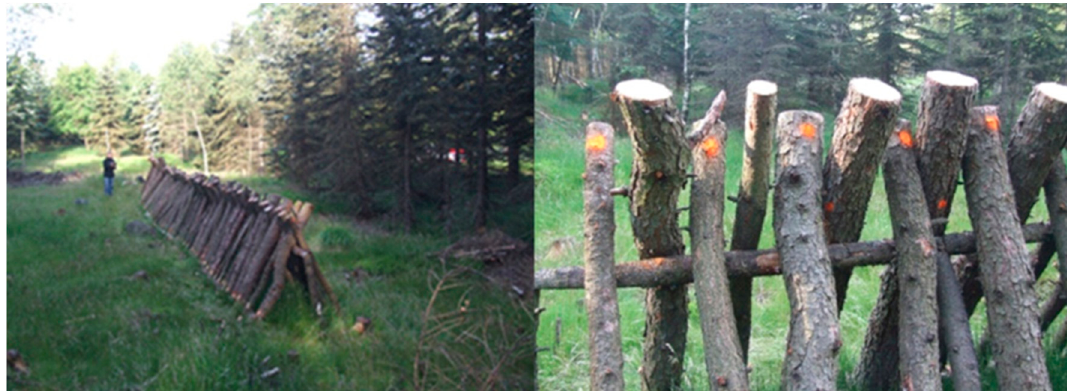
Figure 2. Design of experiment 1: larch logs installed at the Sn ě žník study site in 2014. Photograph by E. Kula.